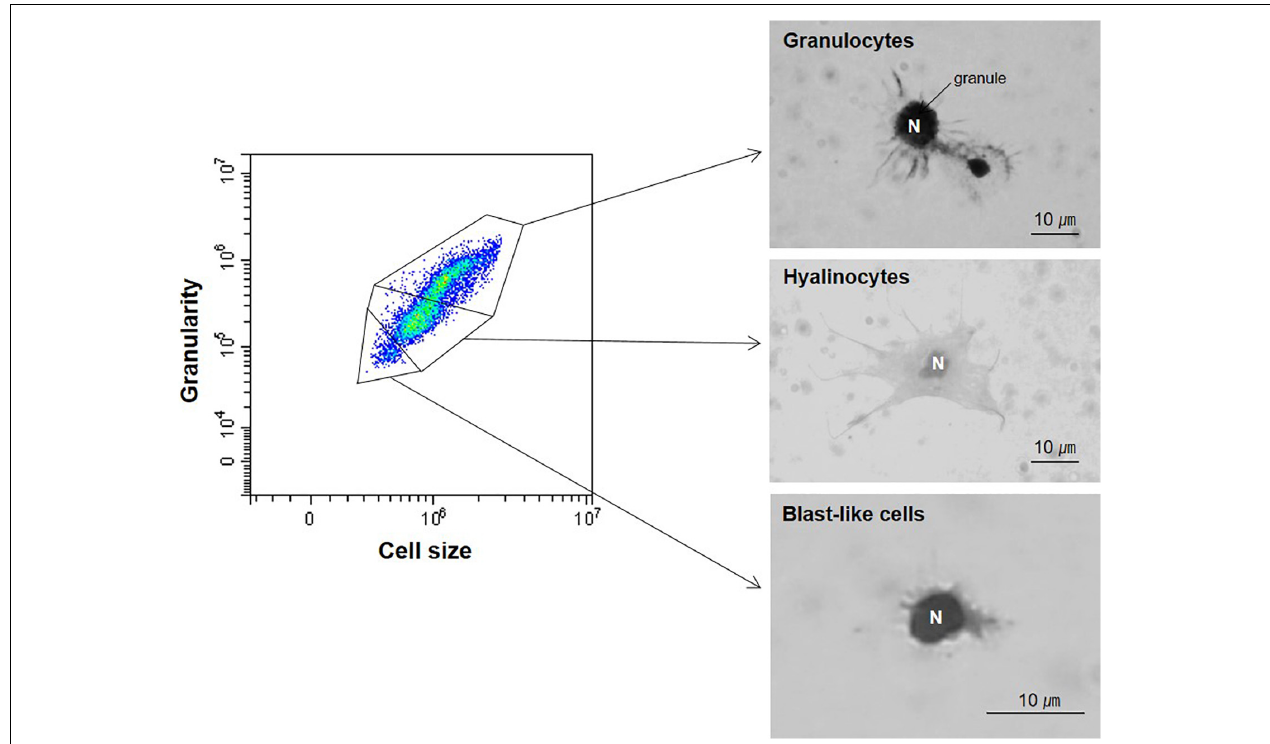
FIGURE 3 | Three hemocyte types from Mytilisepta virgata were determined using a combination of flow cytometry and light microscopy. N, nucleus.